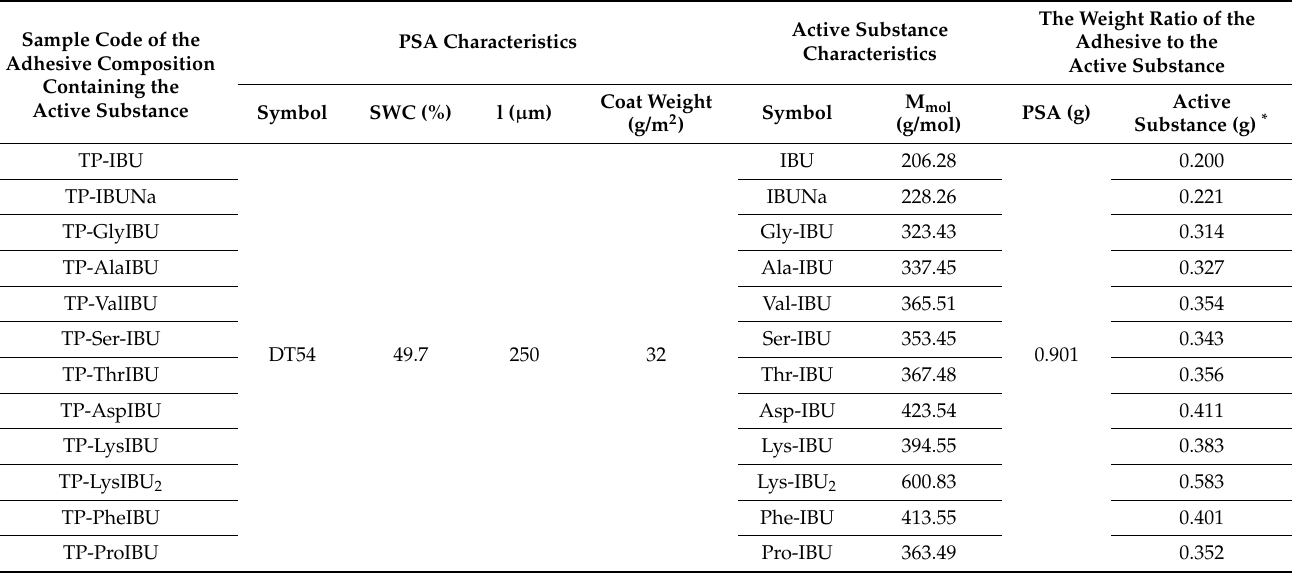
Table 7. The weight ratio of the adhesive to the active substance in adhesive compositions.